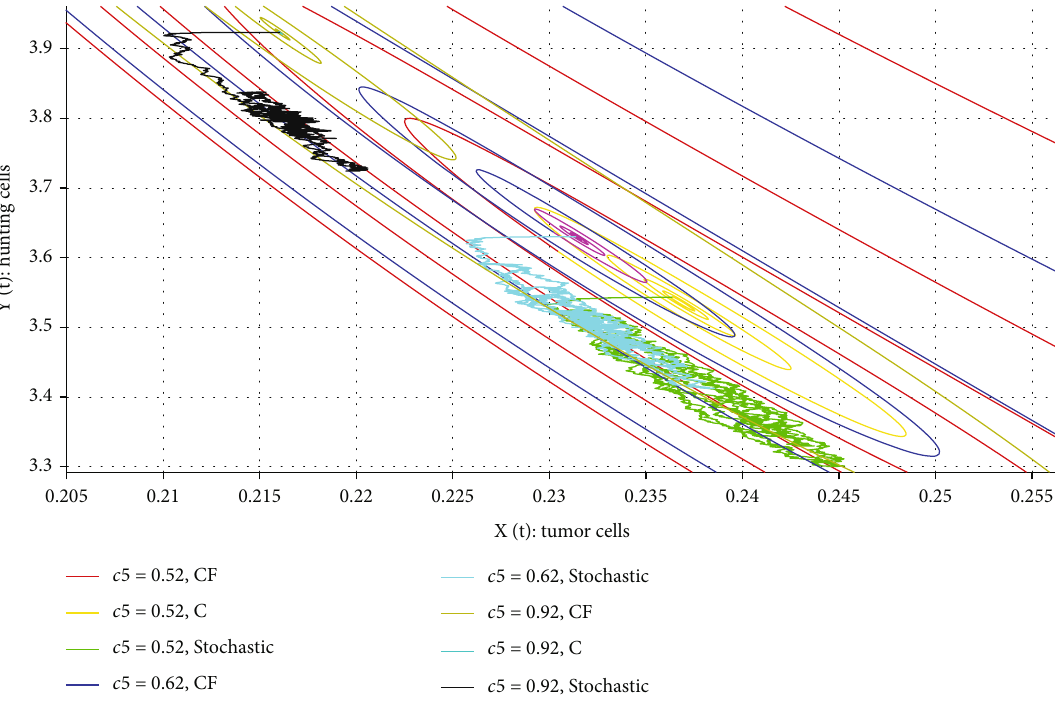
Figure 16: Zooming in on the inner part of Figure